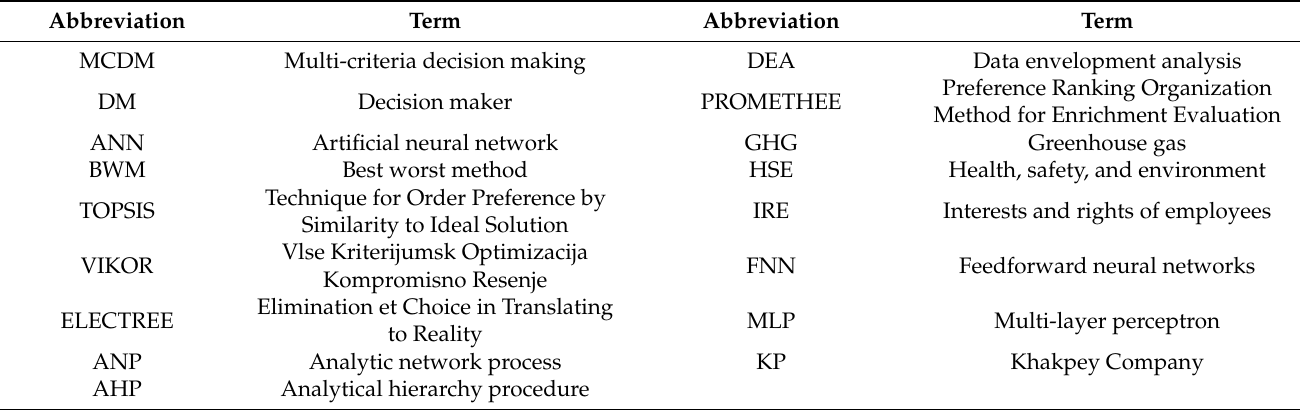
Table 1. Table of